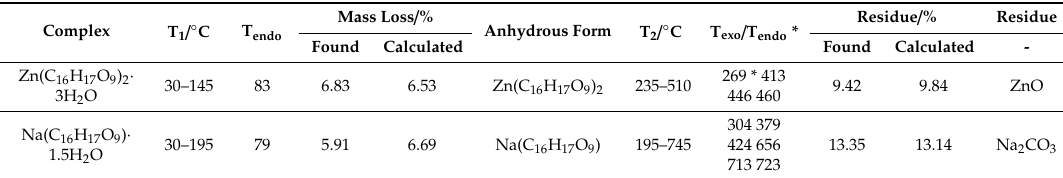
Figure 3. TG-DTG and DSC thermal curves obtained for: ( a ) zinc(II) and ( b ) sodium chlorogenates in air atmosphere. Table 4. Results of thermal decomposition of Zn 5-CQA and Na 5-CQA in air atmosphere. *-endo e ff ect conerns only Zn